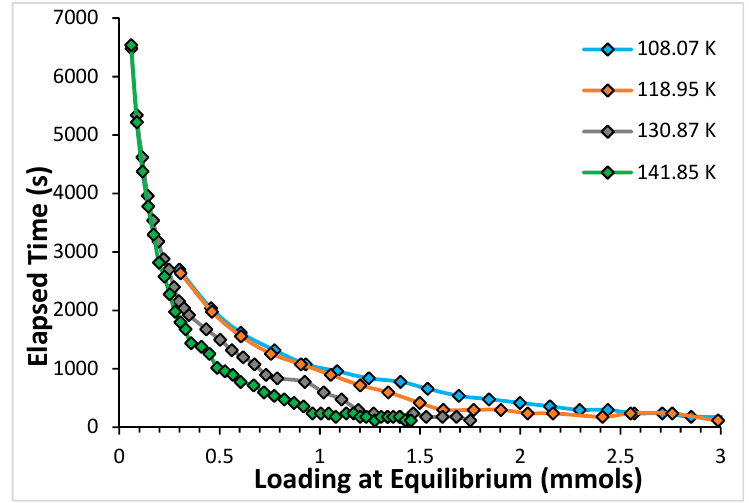
Figure 7. Equilibration times, in seconds, are measured at the point when the sorbent loading reaches 99% of the sorbent loading at equilibrium for the four temperatures studied, as a function of the loading at equilibrium for CF 4 .